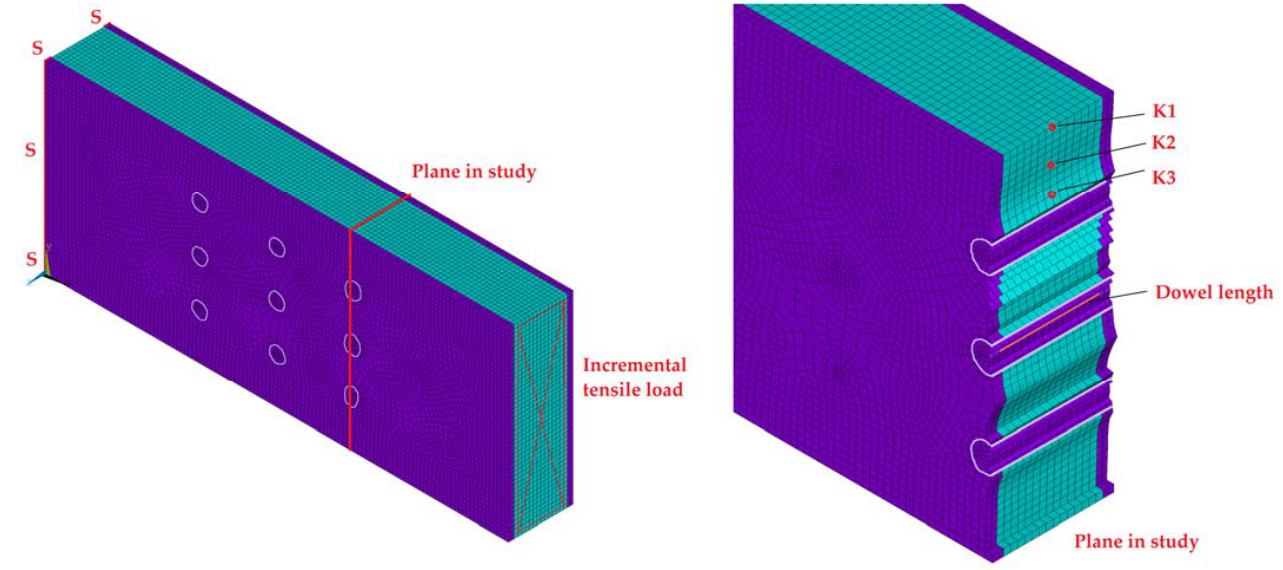
Figure 13. Mesh of the model ( left ) and a representative plane in study ( right ).